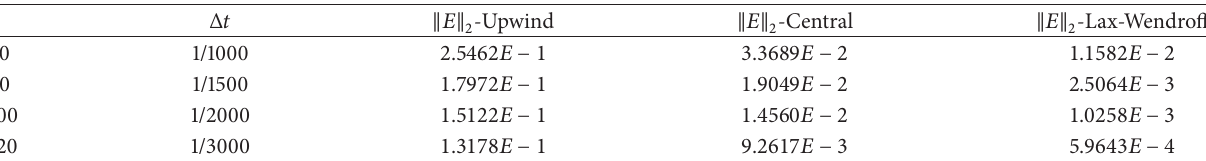
Table 4: The 𝐿 2 errors calculated by the upwind, central and Lax-Wendroff explicit difference schemes with different space steps Δ𝑥 and time steps Δ𝑡 for 𝑑 = 0.02 and 𝛼 = 1.9 at time 𝑡 = 1.5 .